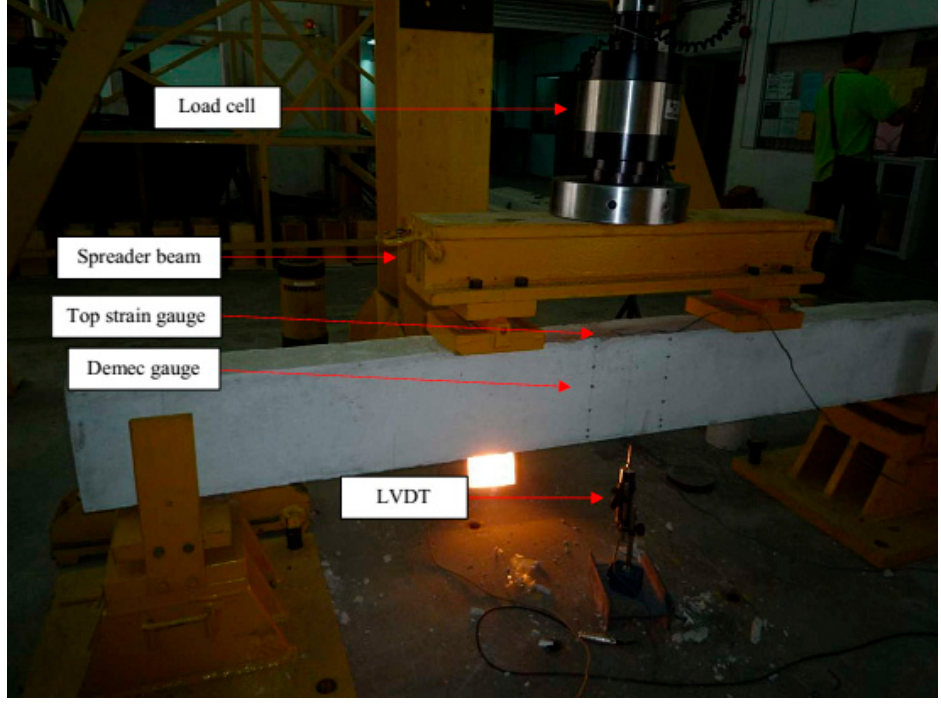
Figure 2. Experimental setup.